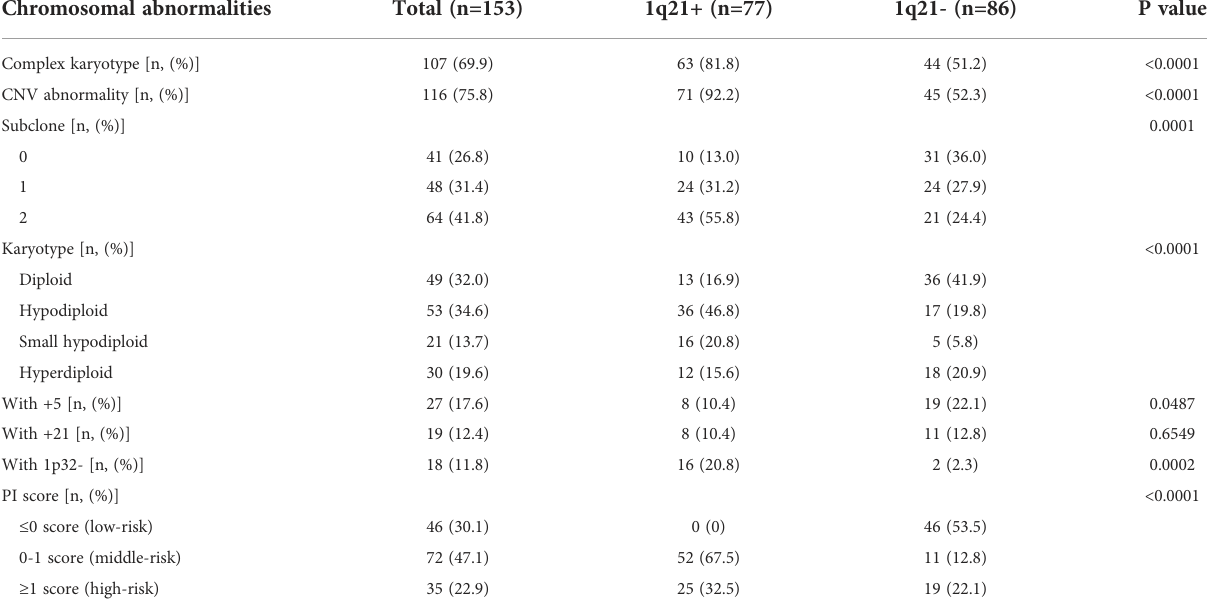
TABLE 3 Chromosomal abnormalities in 1q21+ patients and CKS1B involvement detected by CytoScan. Chromosomal